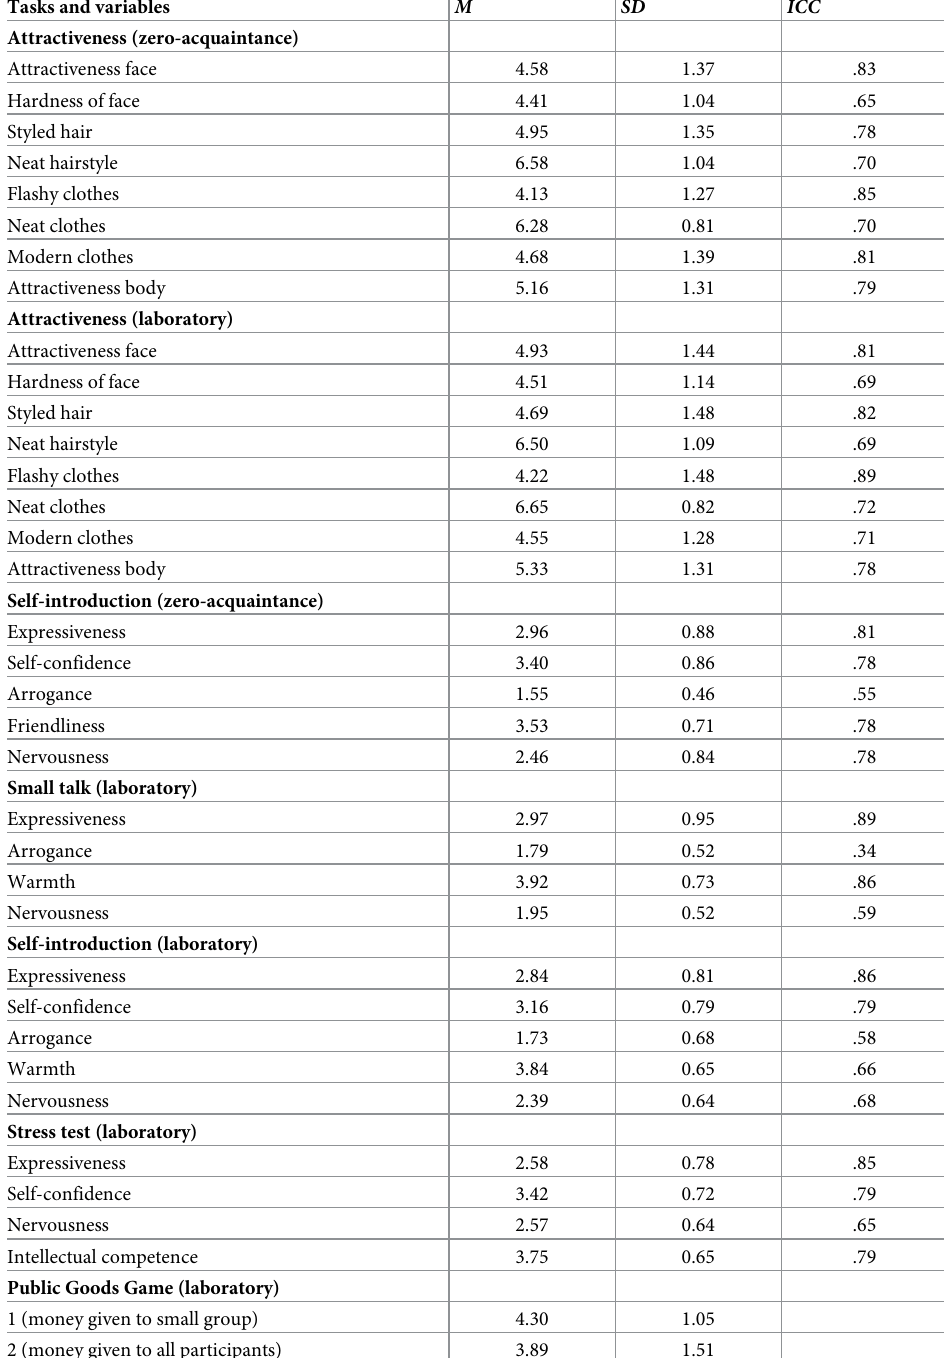
Table 17. CONNECT selected behavior and attractiveness